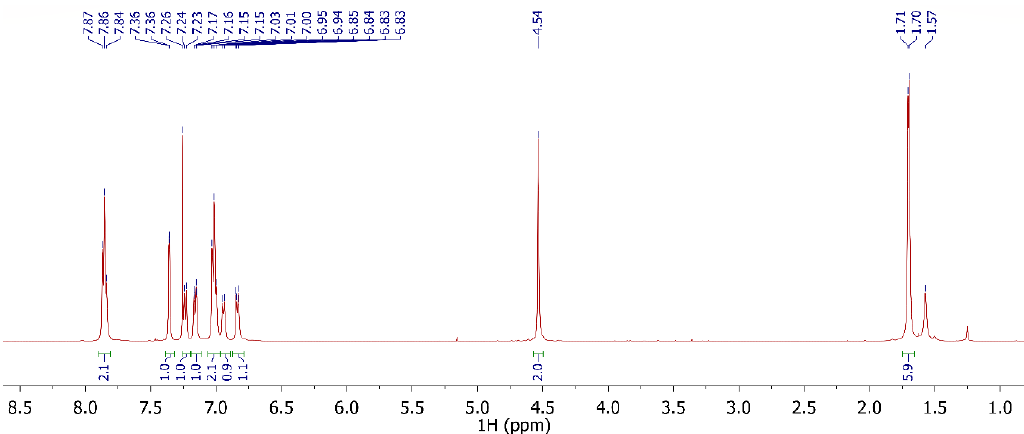
Figure 1. 1 H-NMR of 100% chloromethylated PSU (PSU100) in CDCl 3 .